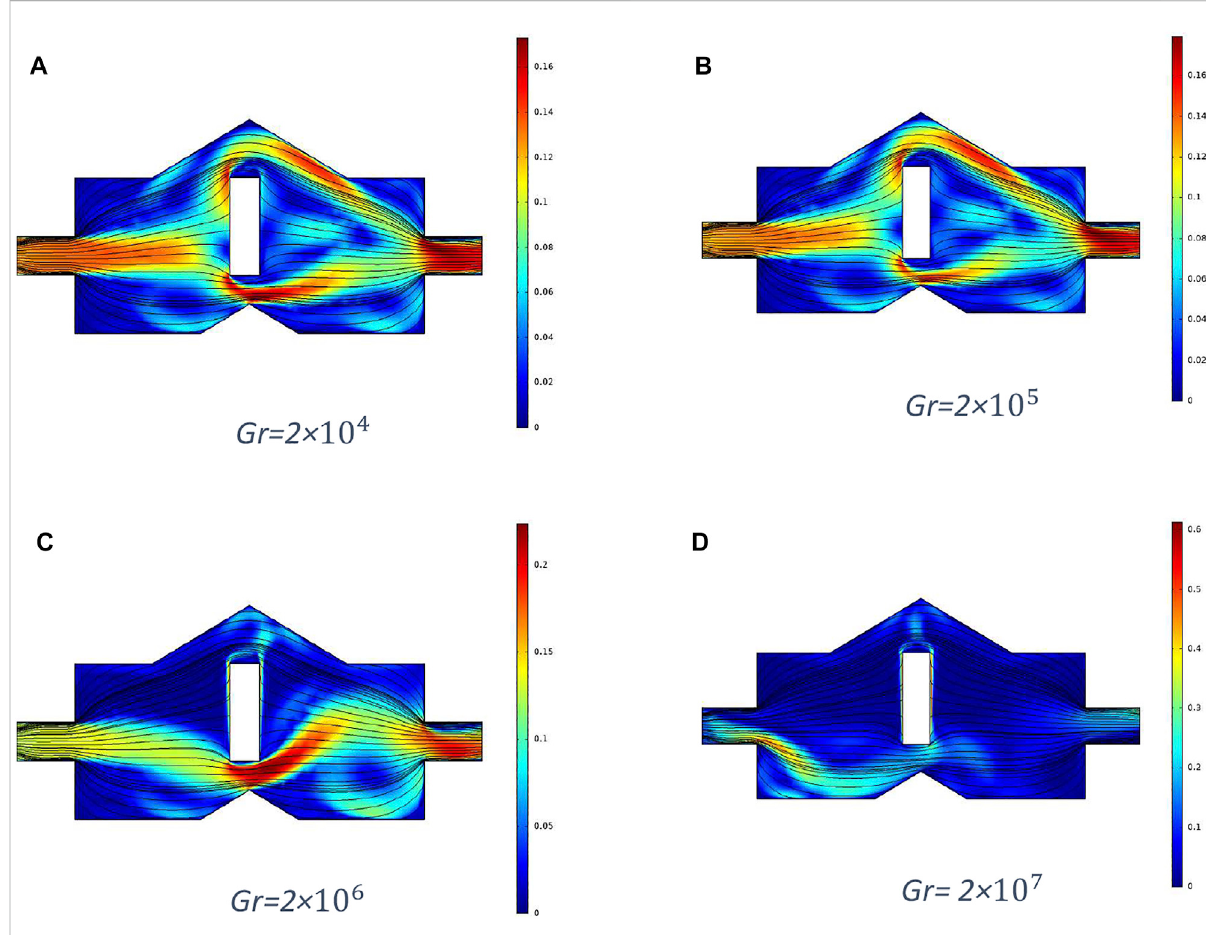
FIGURE 3 Streamlines at Re = 700 and at different Grashof